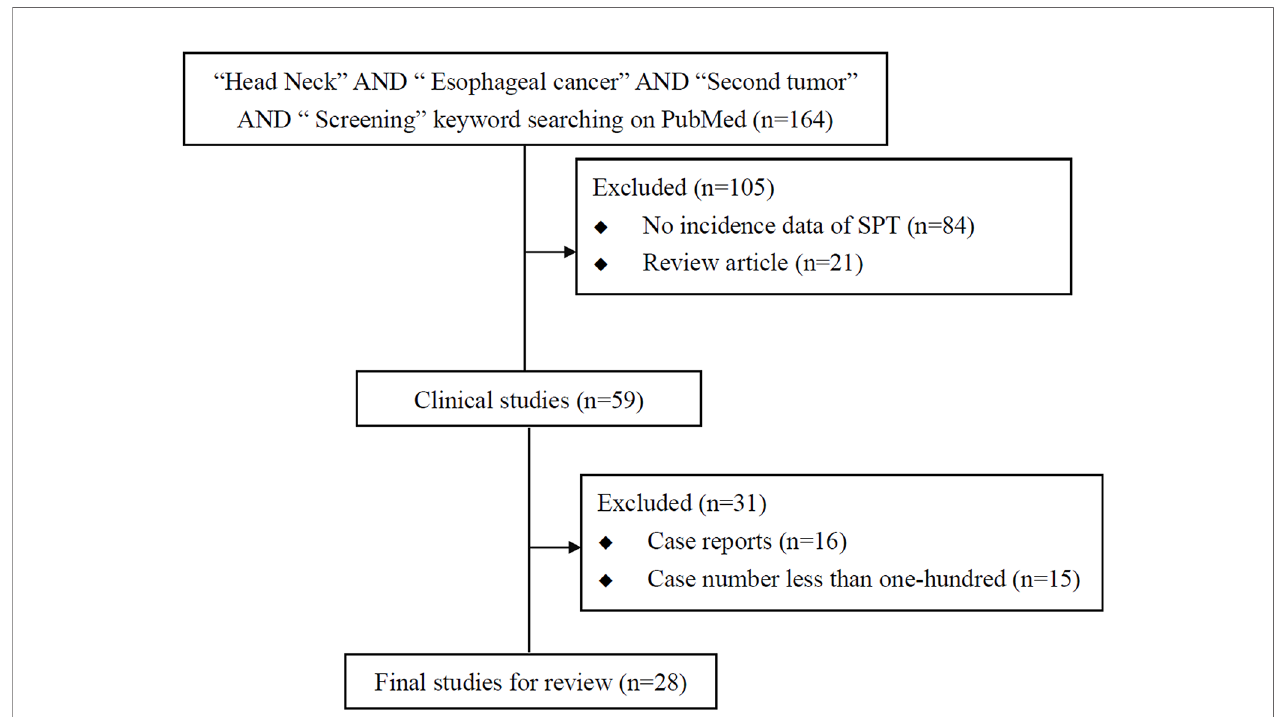
FIGURE 2 | Flowchart of literature review of studies on screening esophageal second primary tumor (SPT) in head and neck cancer patients. TABLE 1 | Prevalence of SPT in HN cancer patients.